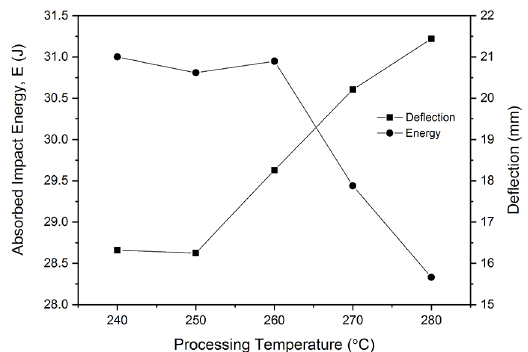
Figure 9 . Energy absorption and damage deflection. (Bibliographic Source: